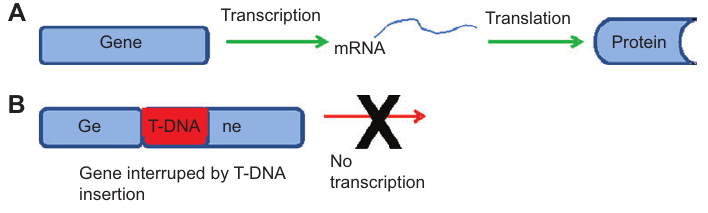
Figure 6 (A) Schematic of a gene transcribed to mRNA and then translated to protein. (B) A gene interrupted by a T-DNA insertion is unable to be transcribed and can result in a complete lack of expressed